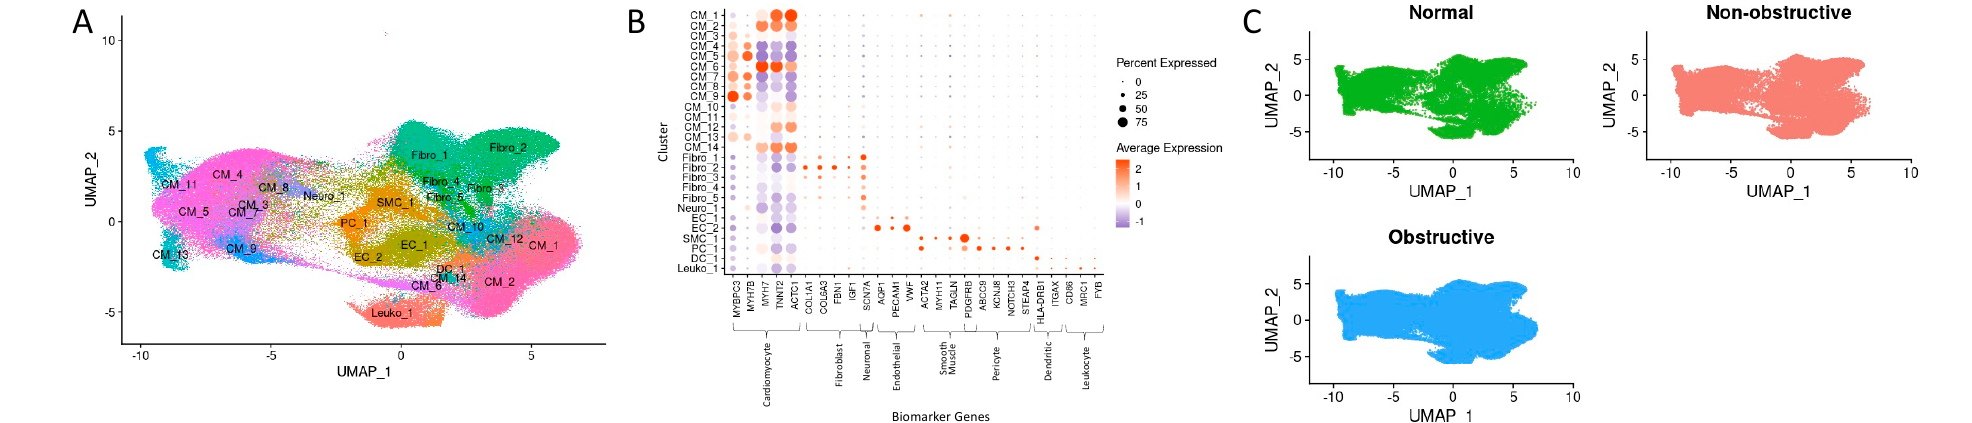
Figure 1. SnRNA-seq cluster identification, biomarker gene expression, and nuclei distribution across conditions. ( A ) UMAP representation of clusters with cell assignment labels. ( B ) Dot plot representation of cell type specific marker genes used to assign cell identity to each cluster. ( C ) UMAP representation of clusters visualized according to disease label.